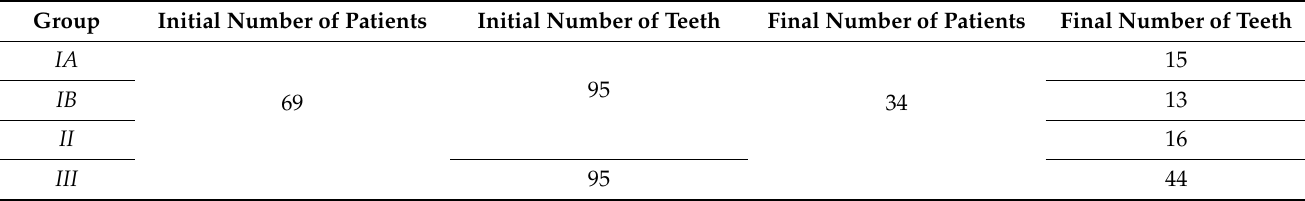
Table 3. Characteristic of study material in allocated groups.